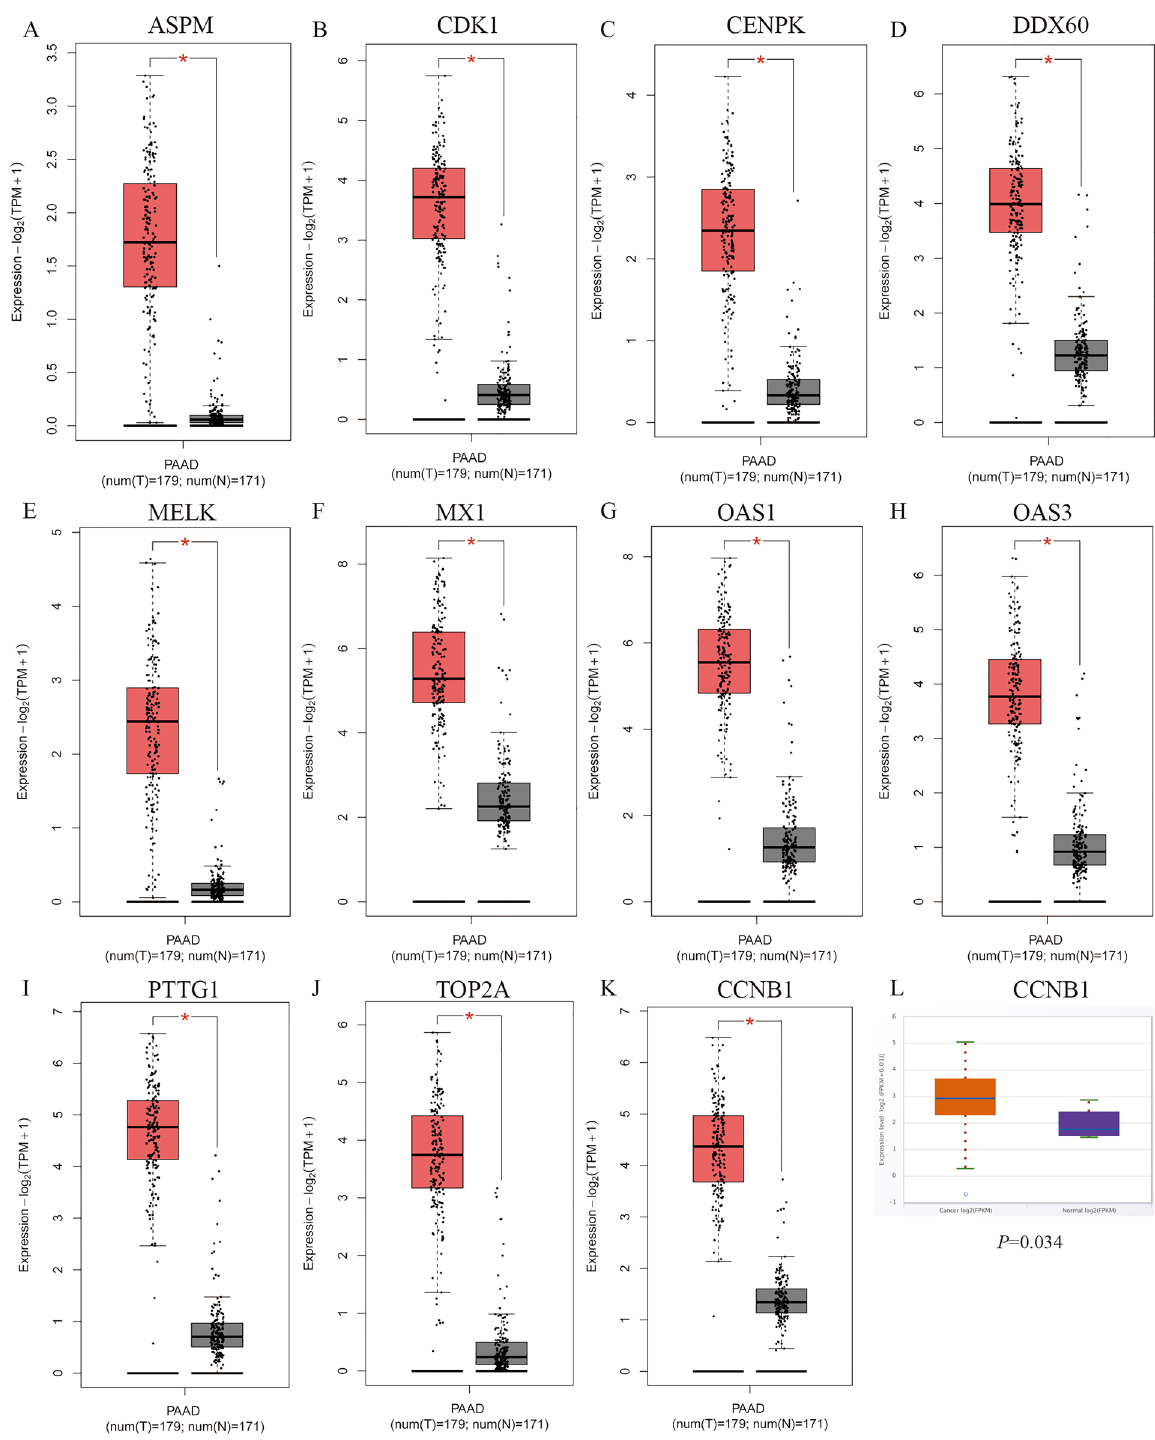
Figure 5. Expression analysis of central genes ( A–K ). Expression analysis via GEPIA; ( L ) expression analysis via